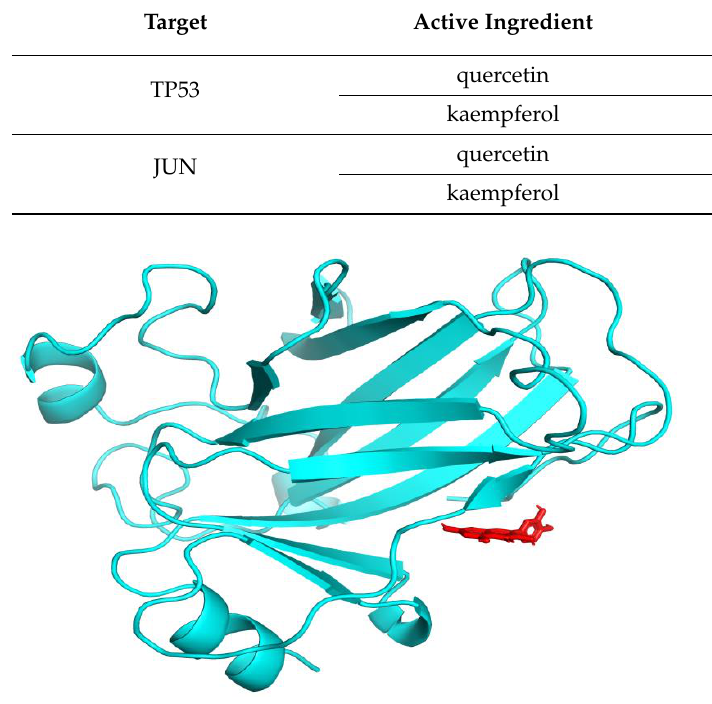
Figure 6. The docking diagram of TP53 and quercetin.